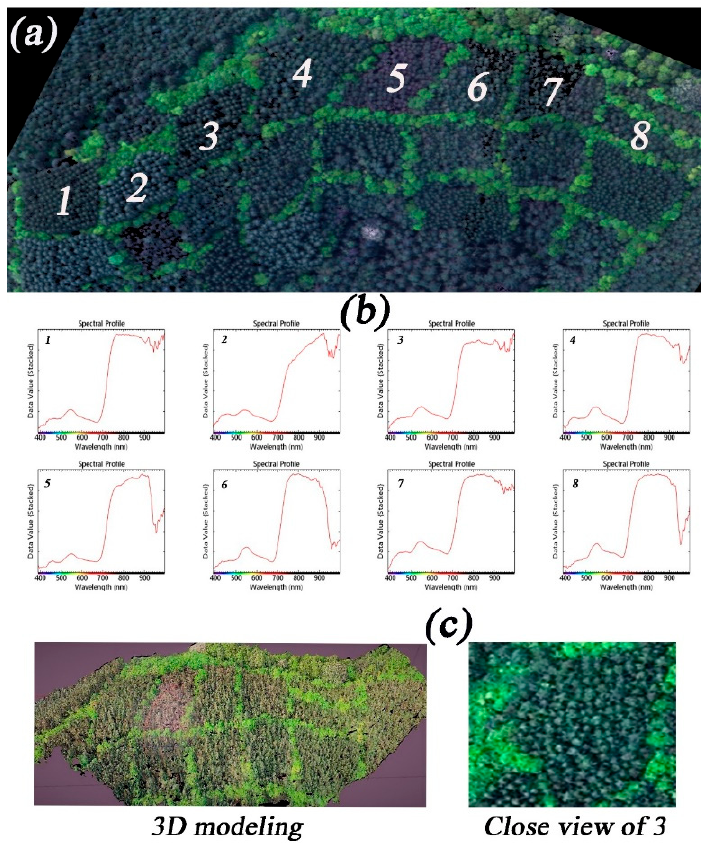
Figure 5. Limitations on measuring the real tree height and DBH of Chinese fir directly by RGB camera.